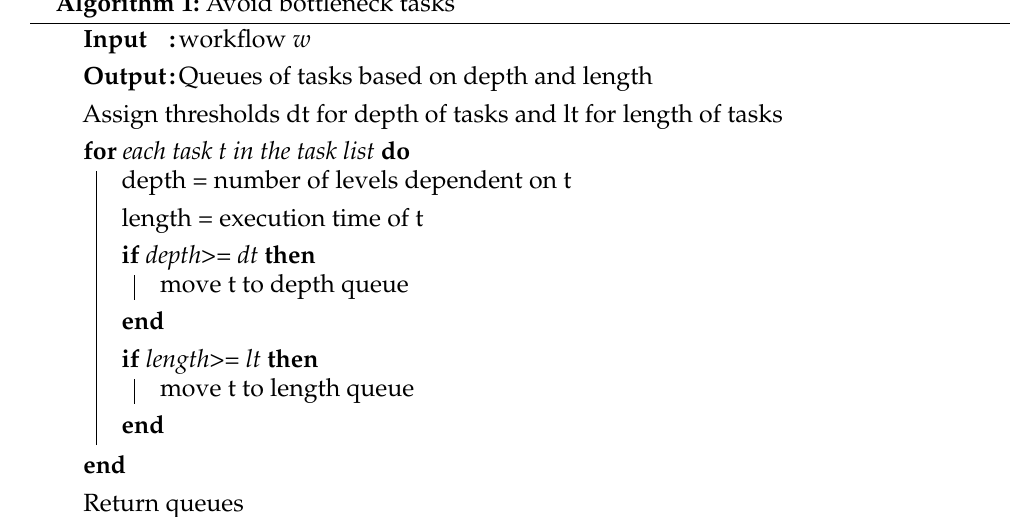
Algorithm 1: Avoid bottleneck